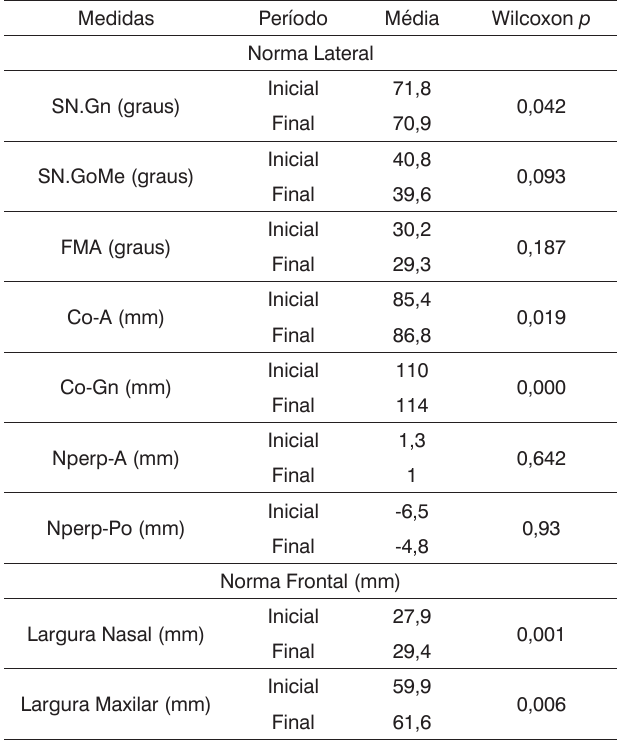
Tabela 4. Médias Iniciais X Finais do grupo 2 B (n =